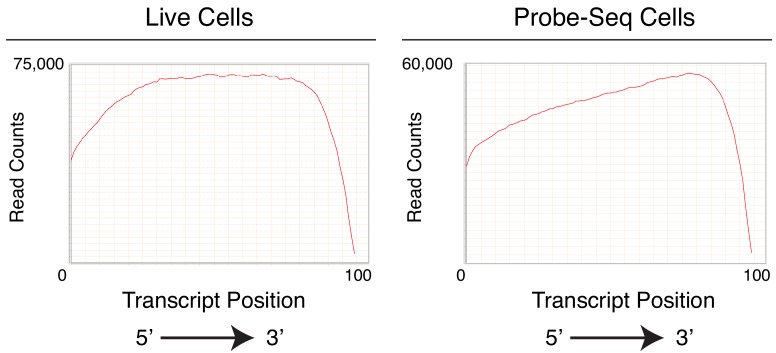
Gene body coverage of Live and Probe-Seq cells show 3’ bias in the Probe-Seq population.Graphs showing gene body coverage of mapped reads from Live (left panel) and Probe-Seq (right panel) cells. Due to cDNA generation using Oligo(dT), cDNA from degraded RNA is biased towards the 3’ end of a transcript. Compared to the uniform distribution along the gene body seen in the Live cell population, the distribution is right-shifted in the Probe-Seq cell population.